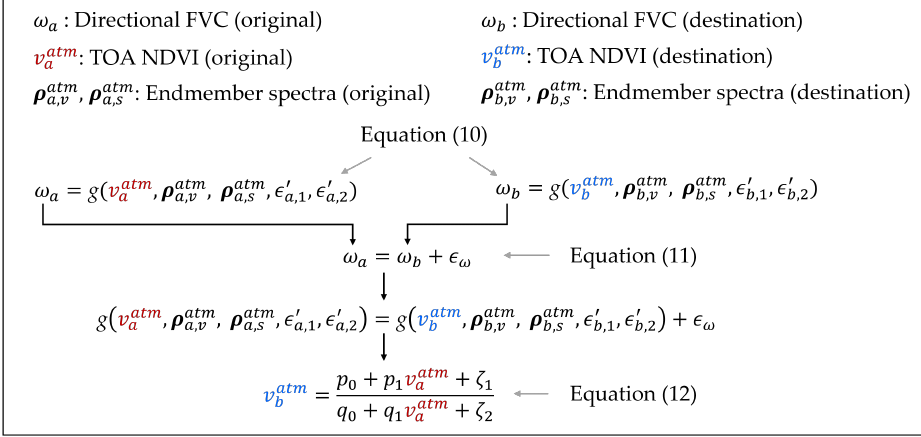
Figure 2. Illustration of the steps in the derivation of the NDVI transformation equation.